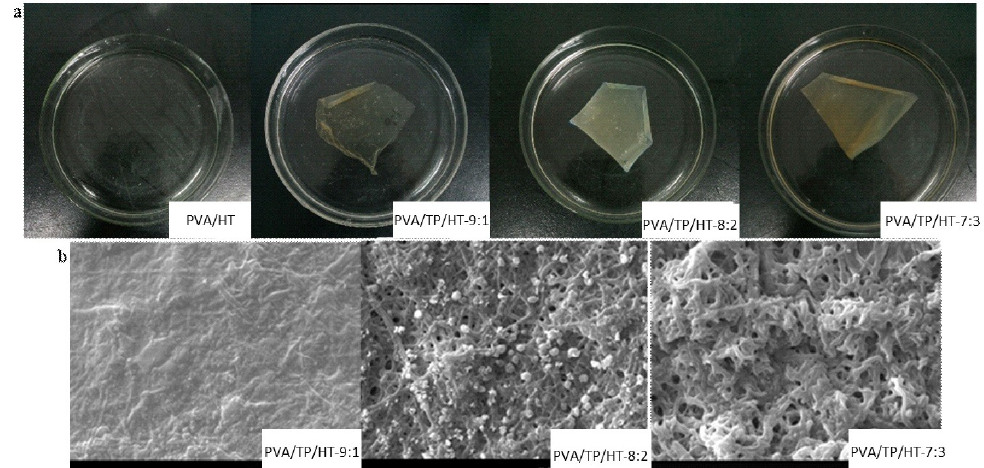
Figure 4. ( a ) Conditions of materials after immersion in water for 24 h; ( b ) fiber morphology after 24 h of